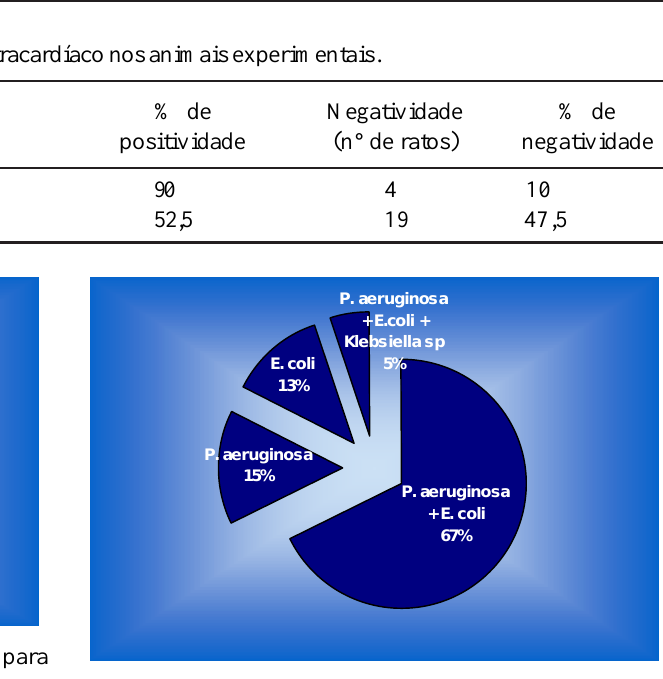
FIGURA 3 - Resultado da cultura peritoneal de acordo com o microorganismo encontrado em percentual de culturas